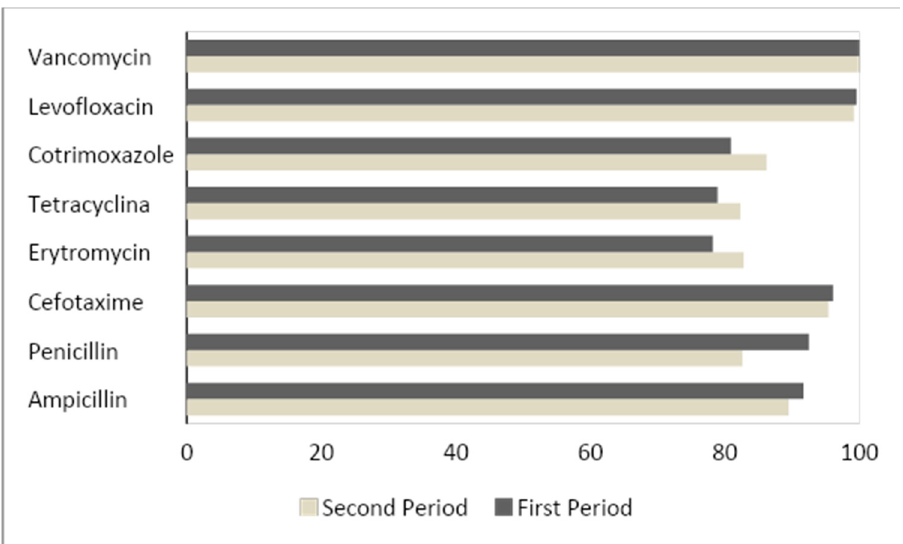
Figure 4. Antibiotic sensitivity profile of our population distributed by periods of study. The results are expressed as a % of sensitivity to each of the different antibiotics. Period 1 (2012–2015); Period 2